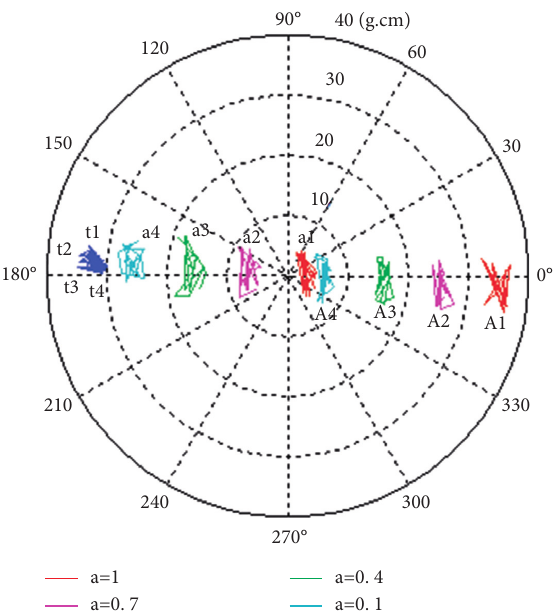
Figure 7: The one-time correcting effect of different weight removing